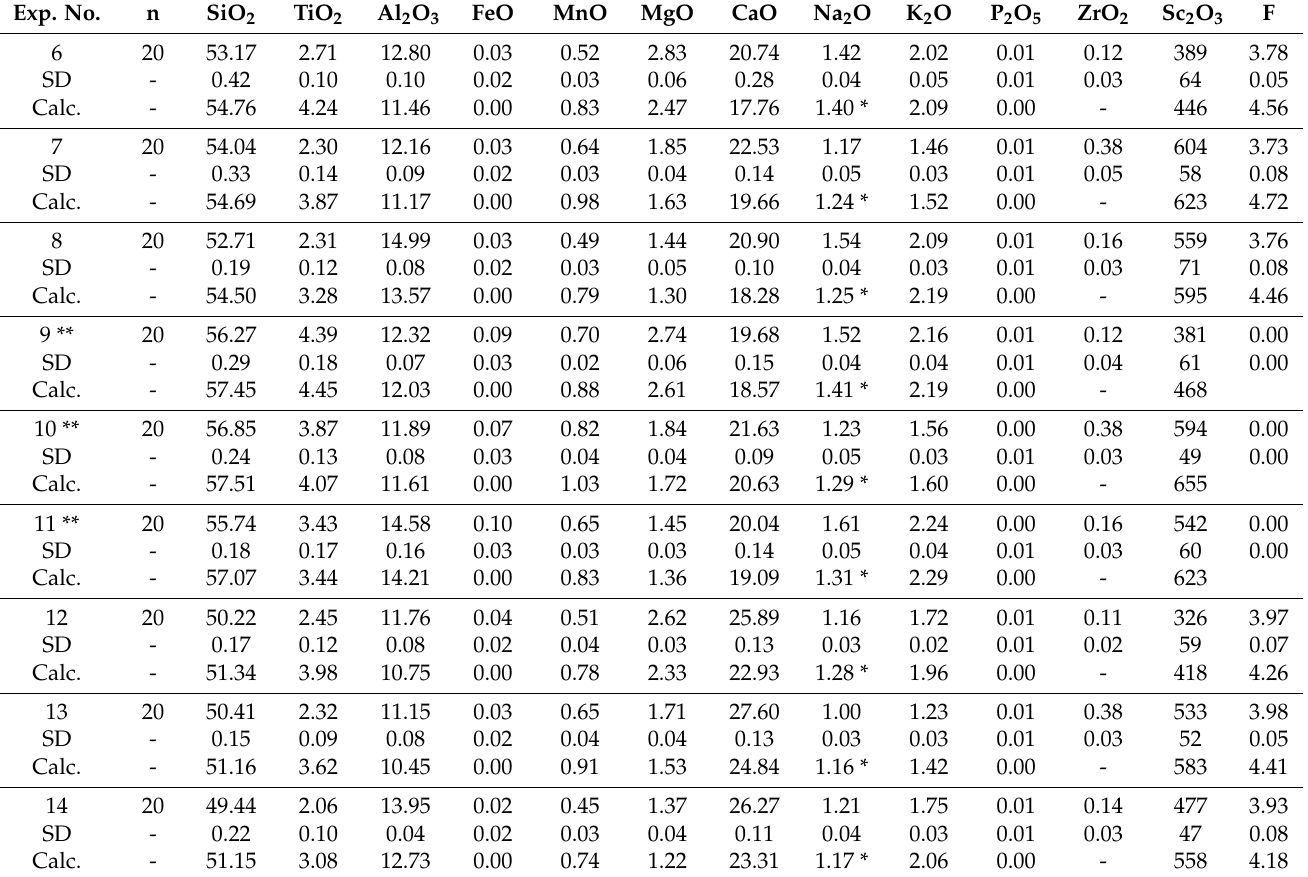
Table 7. Average chemical compositions determined with EPMA for slags produced in reduction experiments 6–14; Sc 2 O 3 ppm, other oxides wt%. n = number of analysis points. Calc = calculated values based on ICP-OES data, excluding FeO and P 2 O 5